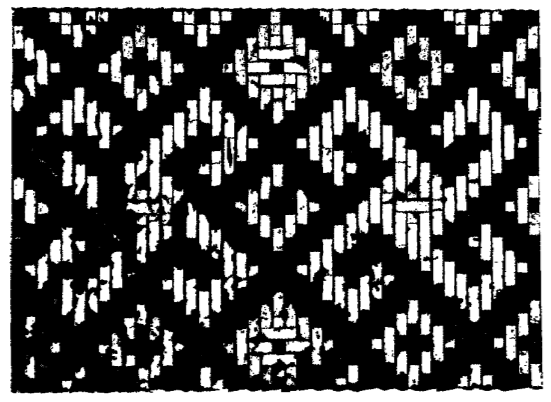
Figure 7. Filtered turquoise bricks in the dome of İnce Minareli Madrasa.